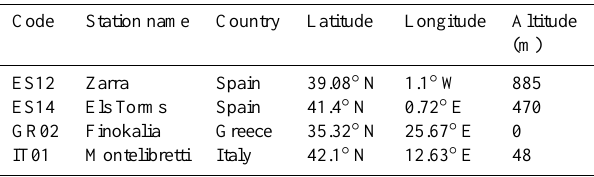
Table 1. EMEP stations used for the comparisons to TOMCAT shown in Fig. 1.